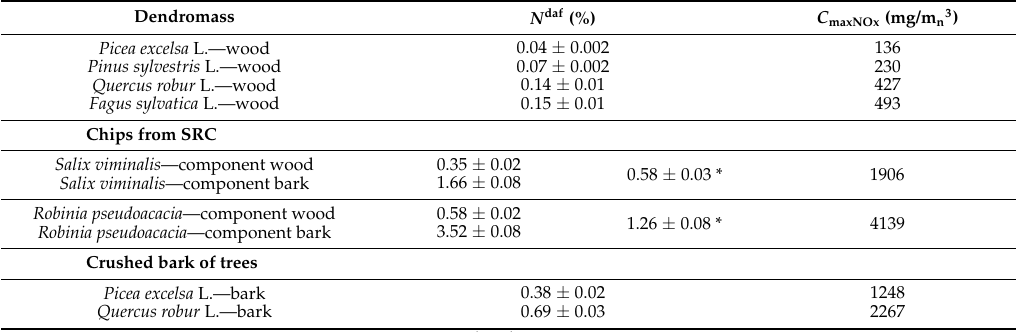
Table 2. Average nitrogen content in the combustible matter of dendromass and theoretical values of maximum concentrations of NO x in the combustion gases (converted to 11% O 2